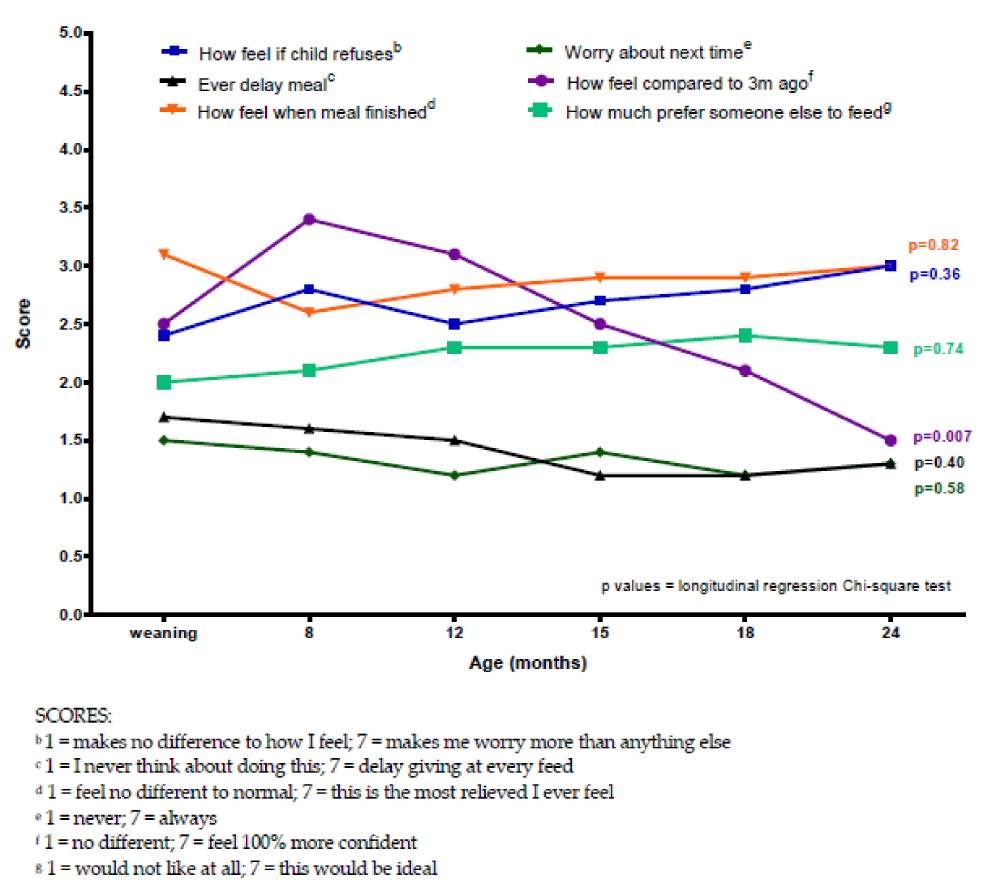
Figure 3. Mean control maternal feelings about feeding their child solid foods at di ff erent child ages in